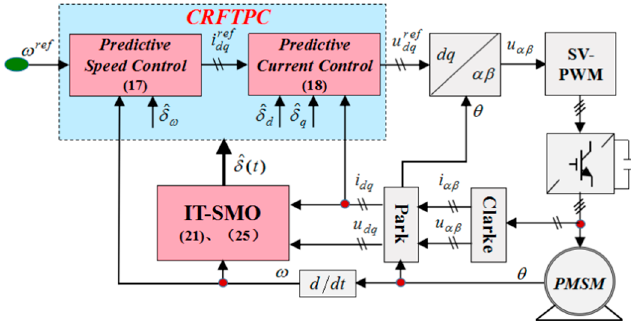
Figure 5. The block diagram of CRFTPC method.